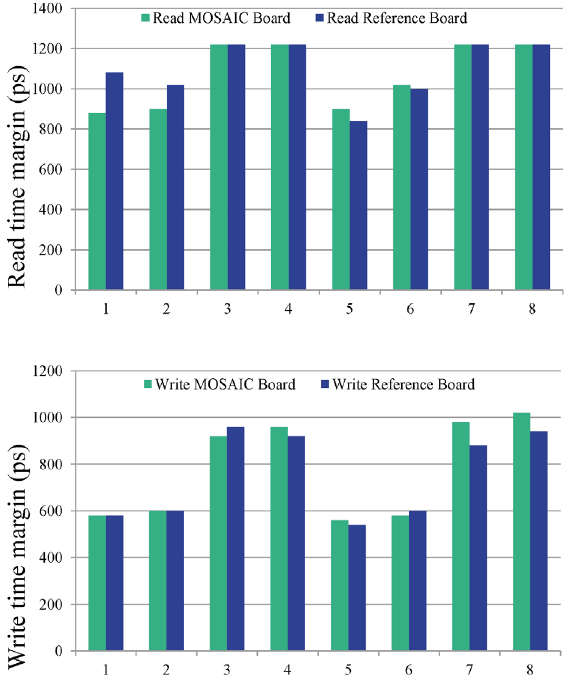
Figure 3. DDR time margin for read operations (top) DDR time margin for write operations(bottom)